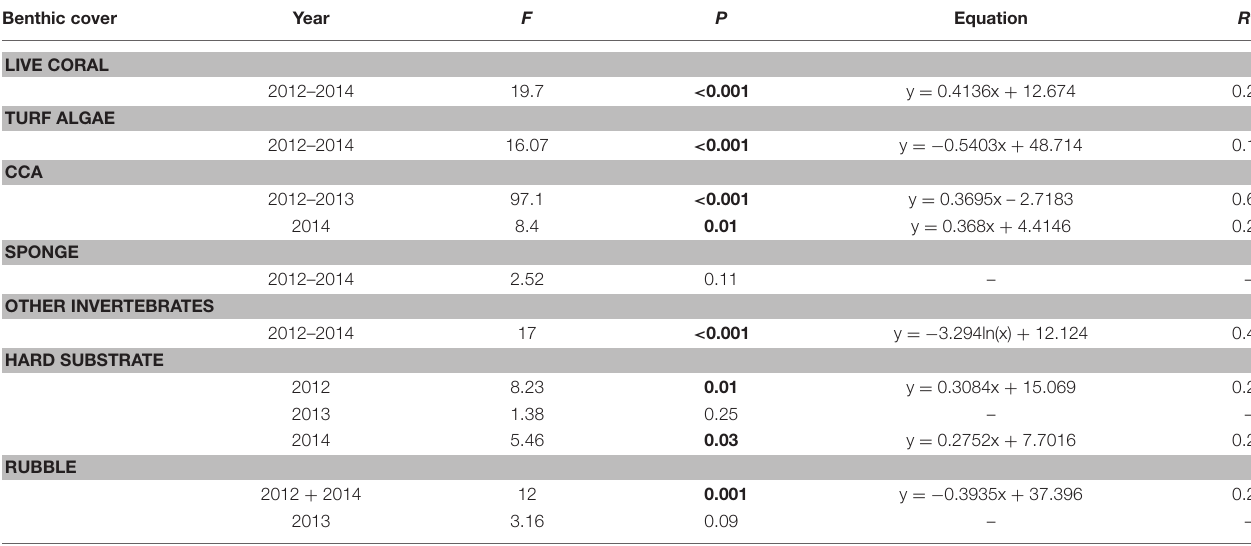
TABLE 3 | Results of regression analyses of benthic cover (%) and substrate type with distance from shore for all benthic variables that showed a significant difference with distance in the PERMANOVA analysis (Table S2). Benthic cover Year F P Equation R 2 LIVE CORAL